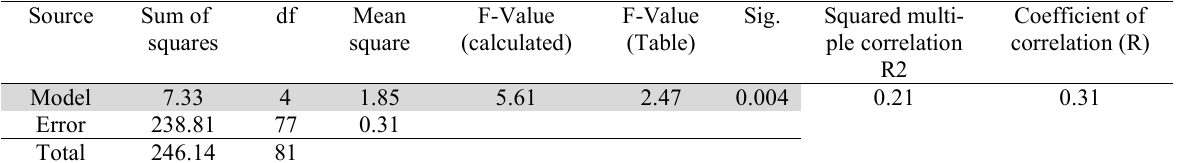
Multiple regression test results of the effect of administrative empowerment in enhancing problem solving and decision- making skills Source